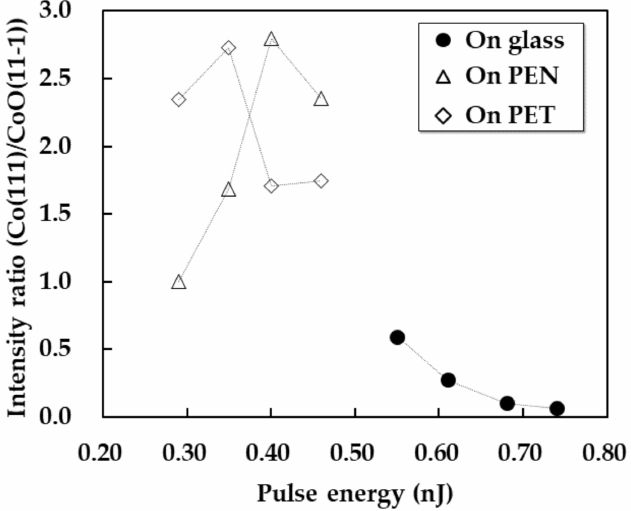
Figure 6. Intensity ratio of Co(111)/CoO(111) of the patterns fabricated at a scanning speed of 5 mm/s on the glass, PEN, and PET